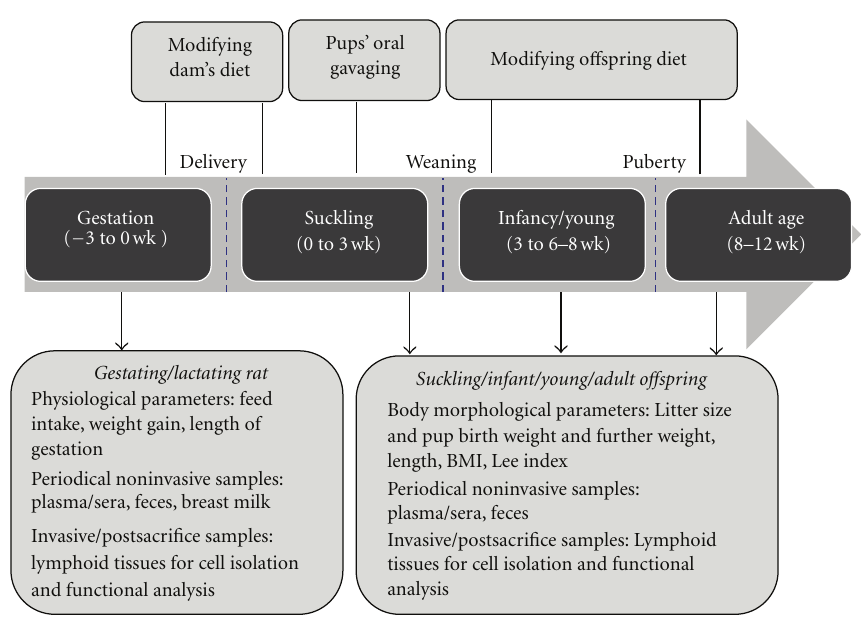
Figure 3: Diagram of the possible designs for experimental nutritional interventions beginning at gestation, through suckling and infancy to rat adult age and main physiological outcomes. (a) Nutritional interventions: maternal diet can be manipulated during gestation (3wk) and/or suckling (3wk) in order to transfer the nutrient to the o ff spring. During suckling, a precise amount of nutrient can be administered to pups by oral gavage. When the pups start eating the solid diet (2-3wk), their diet can also be manipulated up to adult age. The objective of the study will lead the researcher to decide the interventional period (with the experimental diet) and the period in which the e ff ect will be evaluated (end point of the design). (b) Physiological outcomes: samples from the gestating and lactating dams during the study period are needed to confirm nutrient incorporation and later transfer to pups (i.e., breast milk and plasma). Plasma and feces are noninvasive samples that can also be obtained periodically from the developing animals and are useful for immune determinations such as cytokines or immunoglobulins. At the end of the study, immune lymphoid tissues can be obtained for cell isolation and further phenotypic and/or functional studies (usually after ex vivo culture under